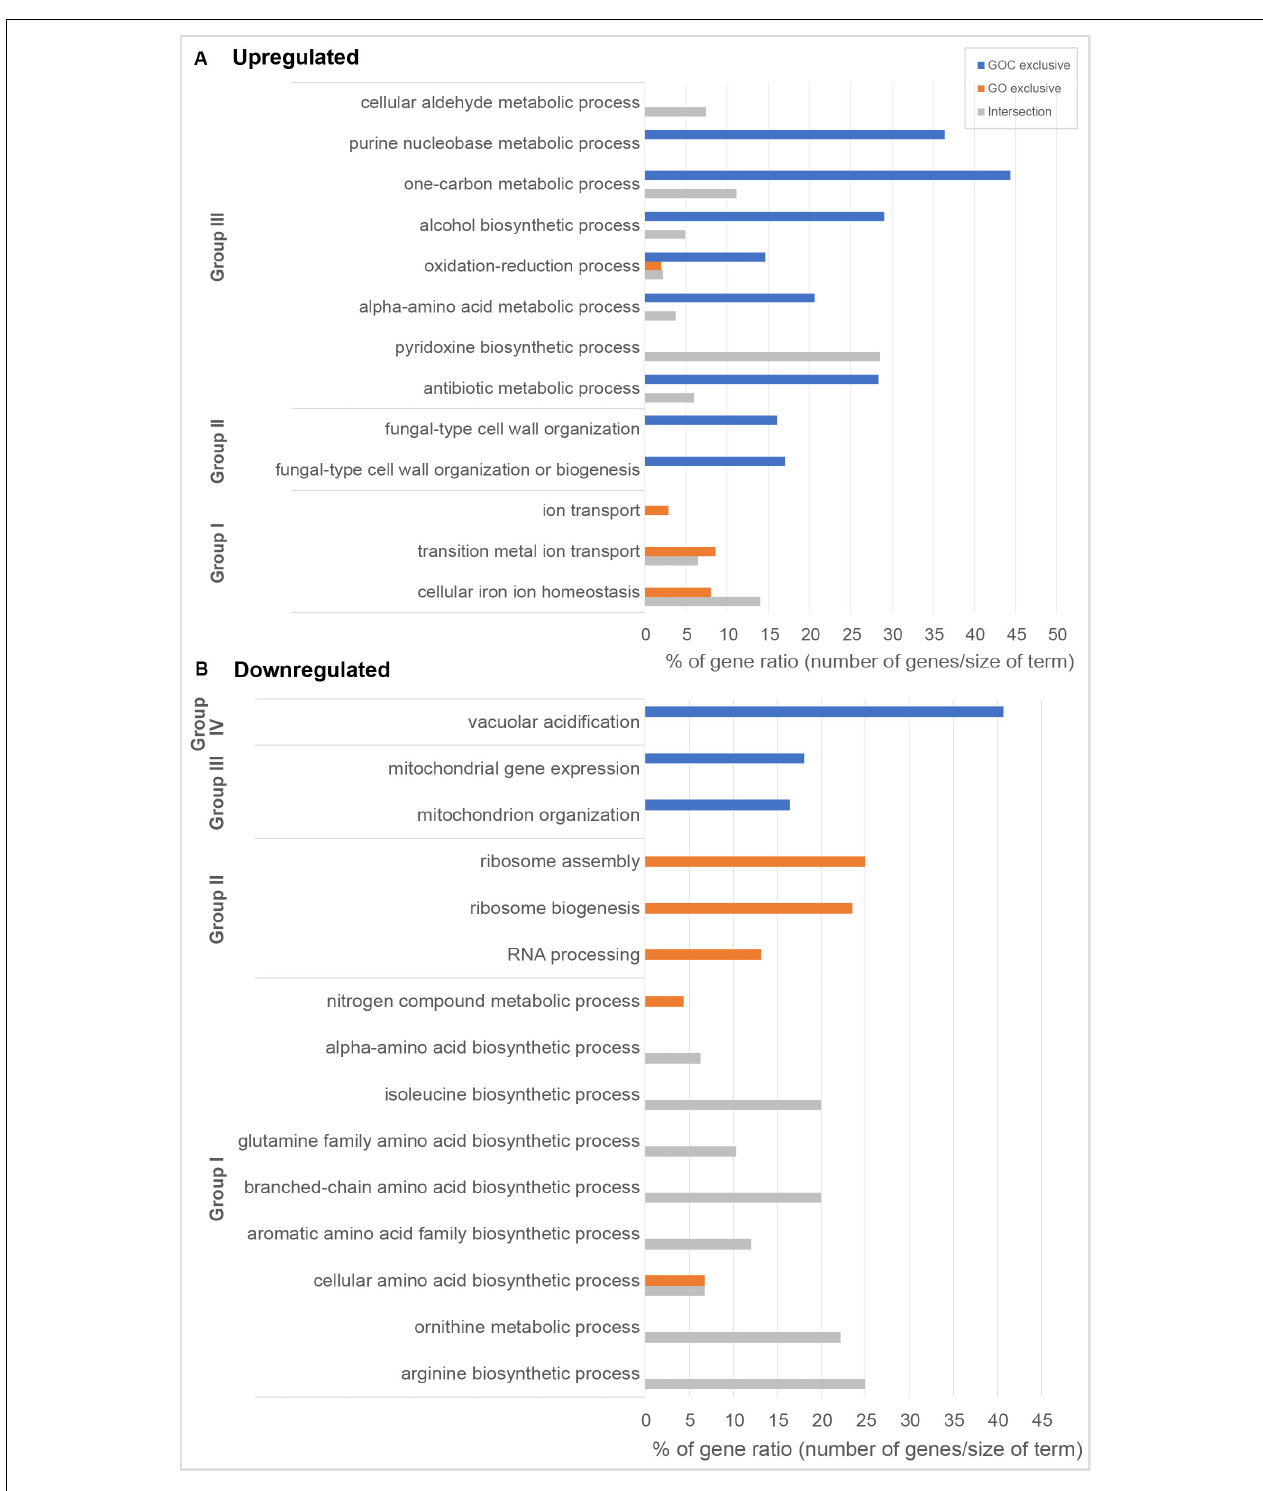
FIGURE 4 | Overview of gene ontology enrichment analysis of S. cerevisiae (A) upregulated and (B) downregulated genes. Blue and orange bars indicate terms enriched among the genes exclusively differentially expressed upon GOC or GO exposures respectively, while gray is used for terms found among the genes commonly differentially expressed in both exposure conditions. Bar size indicates the % of genes in the whole genome annotated to the corresponding term that have been found in each of the exposures. Gene ontology entries have been grouped in terms broadly related to (A) Group I: metal bioavailability, Group II: cell wall structure, and Group III metabolism and in (B) Group I: amino acid metabolism, Group II: protein translation, Group III: mitochondria, and Group IV: vacuolar acidification. All selected terms have an FDR lower than 0.05.